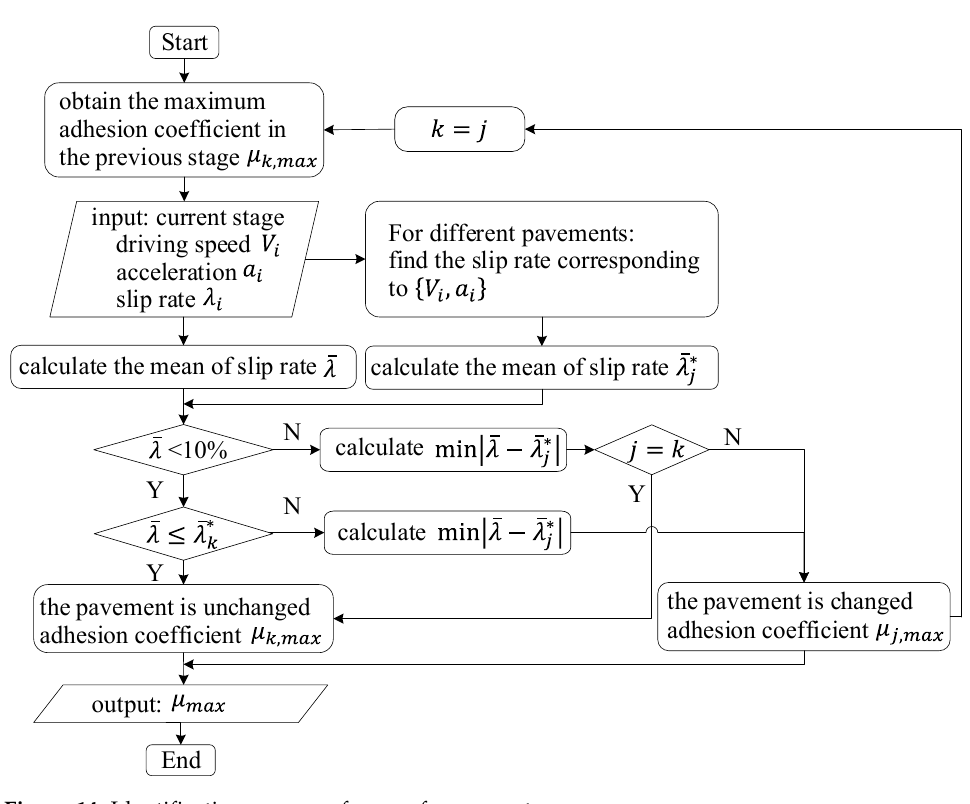
Figure 14. Identification process of µ max of pavement. By setting the corresponding parameters, different combinations of pavements are identified, as shown in Figure 15: